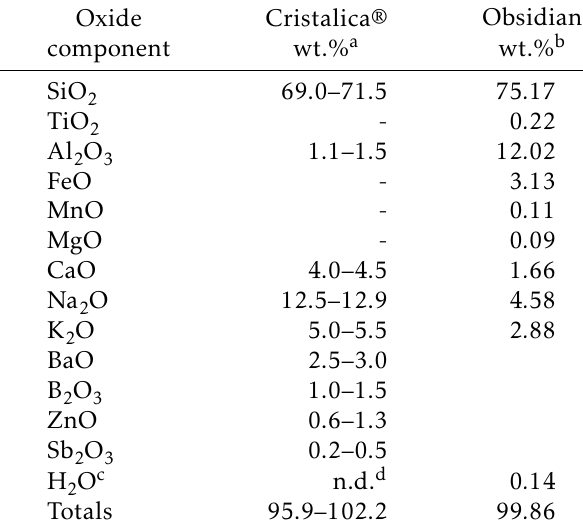
Table 2: The bulk composition of the glass used here expressed as weight percent major oxide